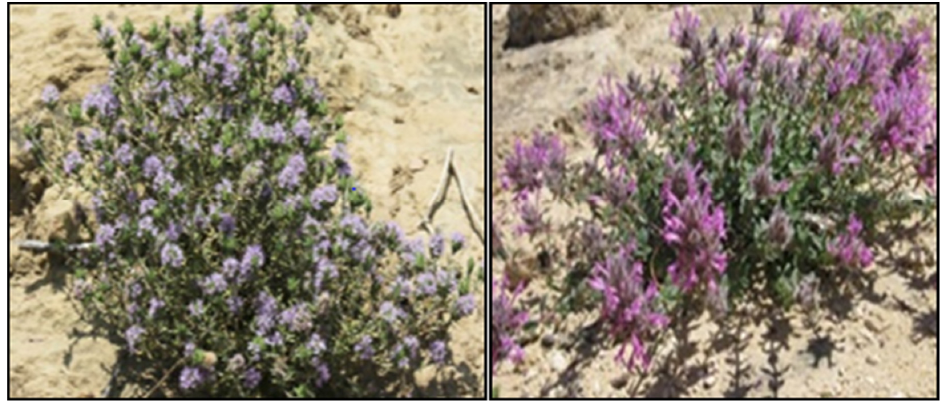
Figure 5. Morphological profile of T. capitatus ( Left ) and T. broussonetii ( Right )